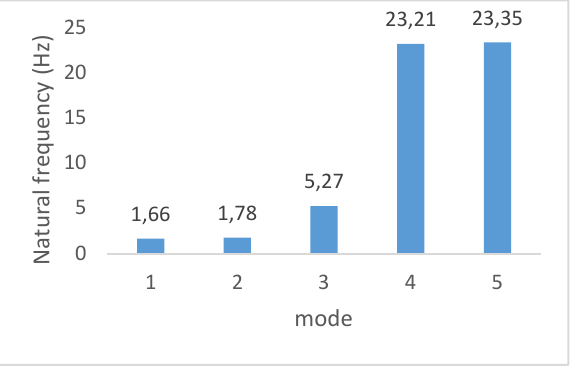
Fig. 9. Natural frequncies of the light sculpture element from a modal analysis in Ansys.